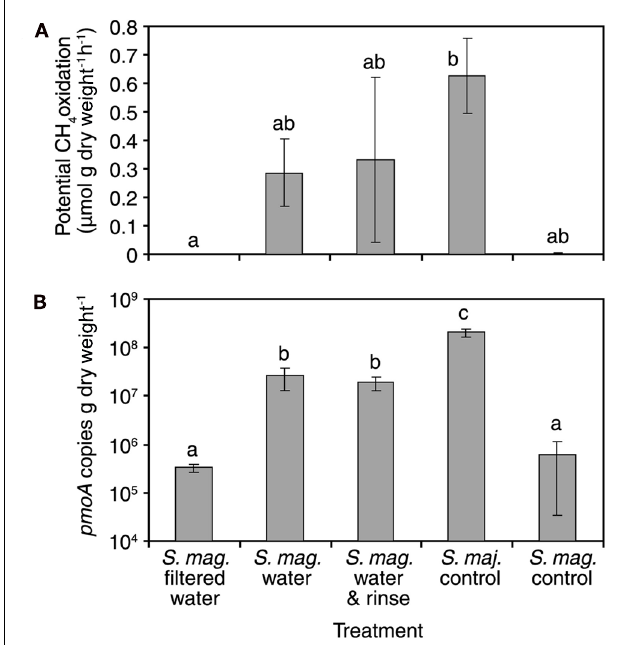
FIGURE 4 | CH 4 oxidation potentials (A) and pmoA copy numbers (B) of differently treated moss samples ( S. mag. = Sphagnum magellanicum , S. maj. = Sphagnum majus ). Standard error bars are shown ( n = 3). Same letter superscripts denote non-significant differences among treatments in the potential oxidation rates. Note the logarithmic scale on the y -axis (B) .